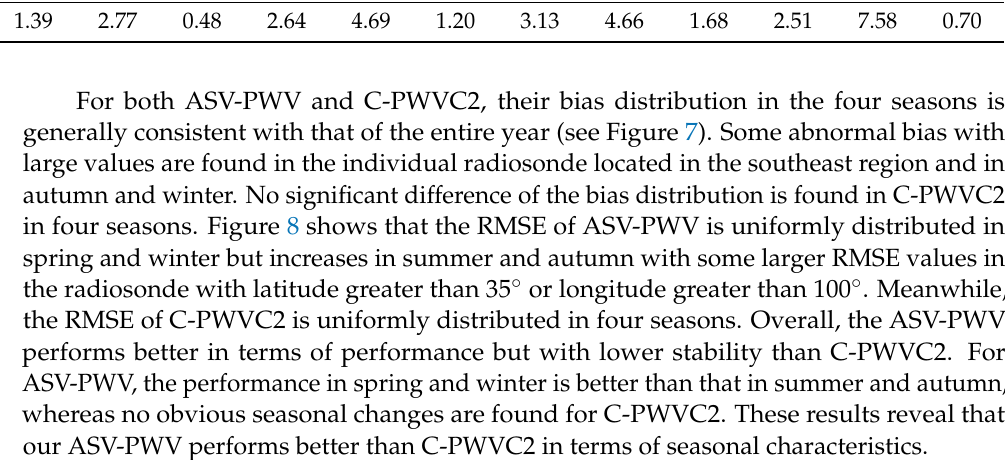
Figure 6. Average annual bias and RMSE of the ASV-PWV and C-PWVC2 in 2020.